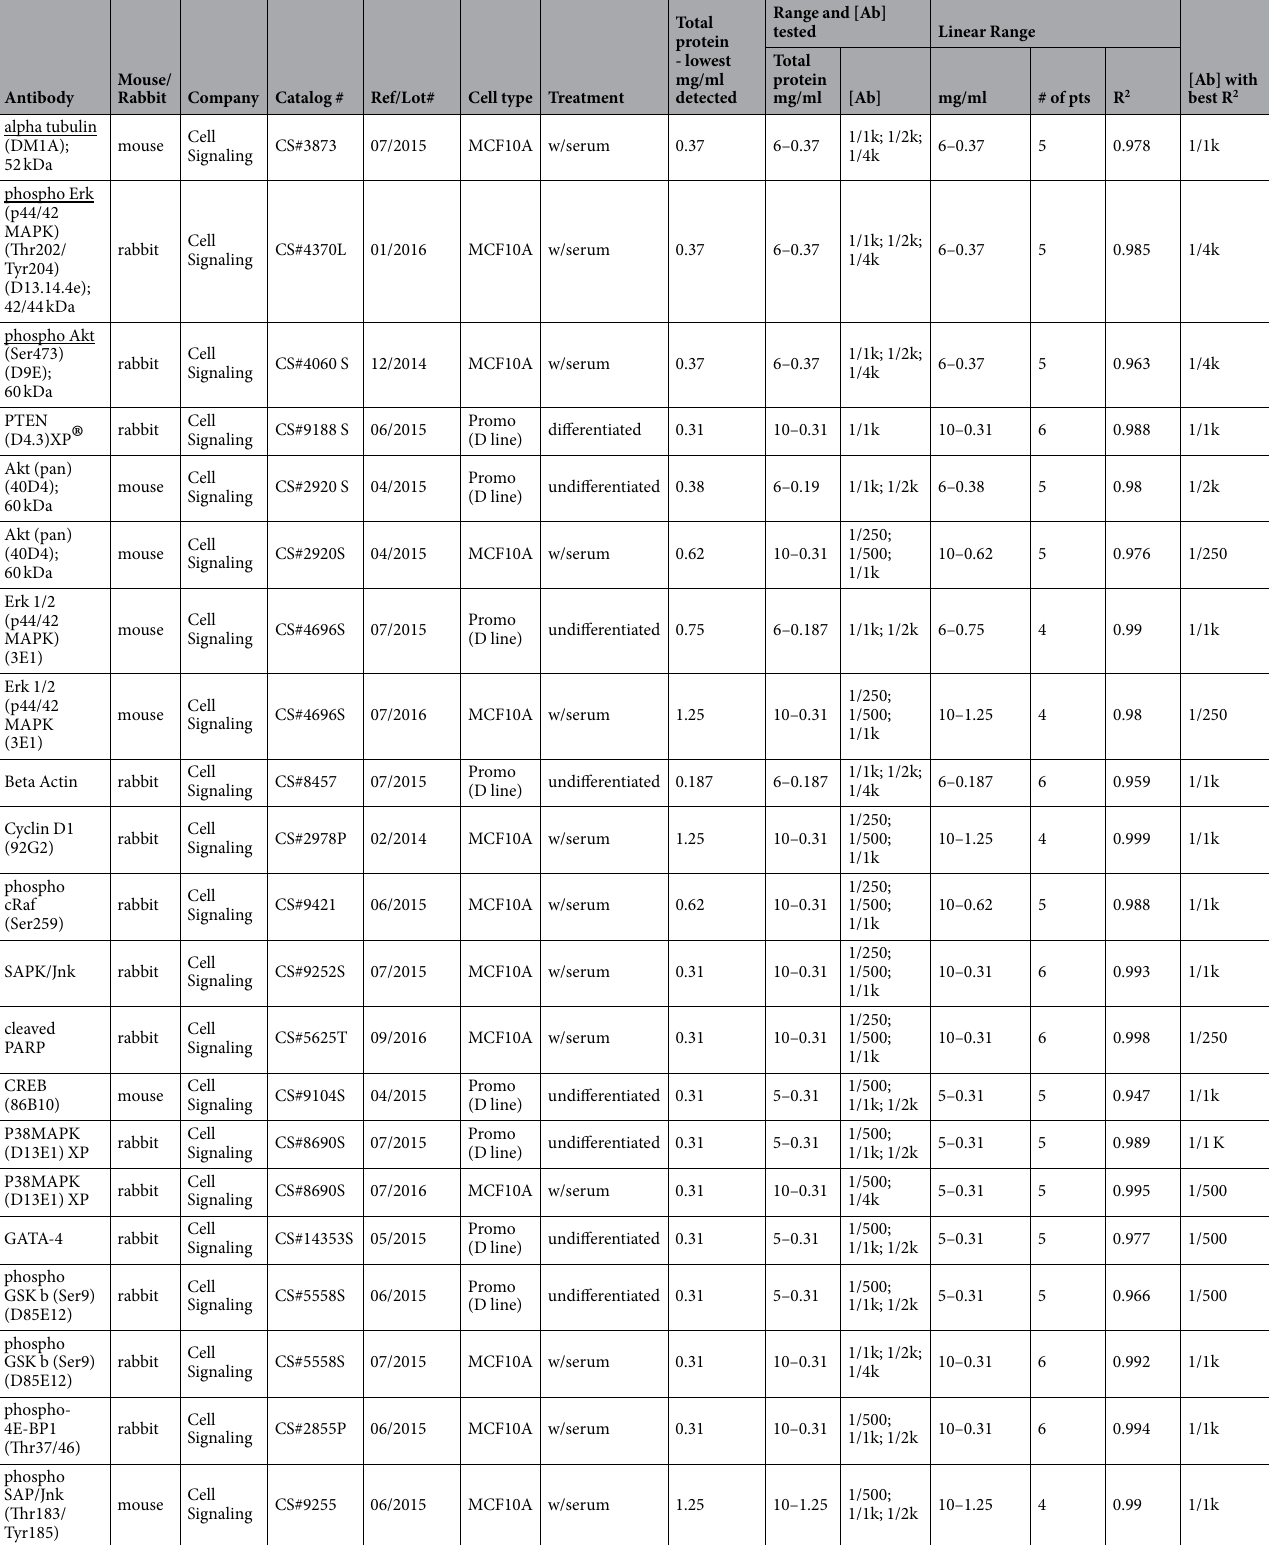
Table 1. Ab Validation for MWA (all Ab’s were at correct